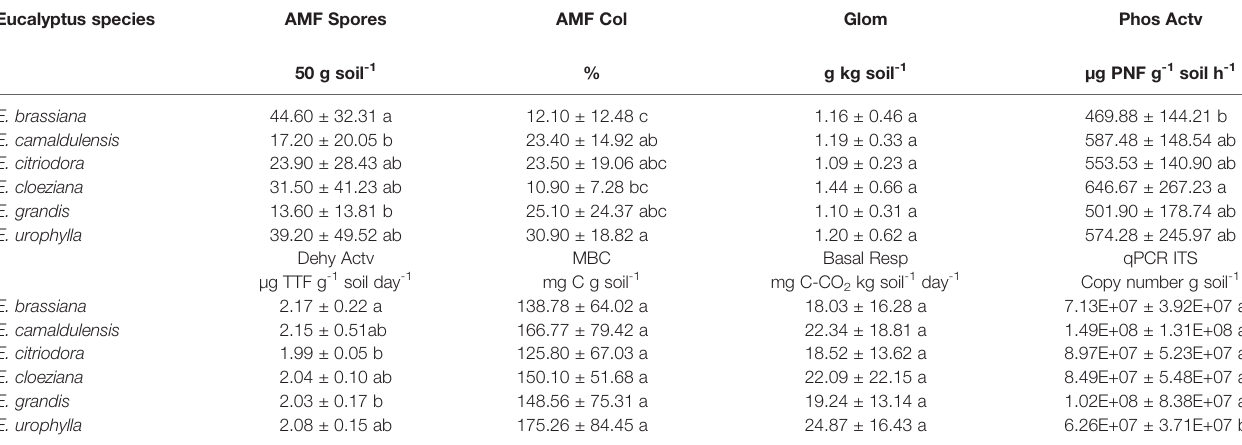
TABLE 2 | Soil microbiological attributes in Eucalyptus species.